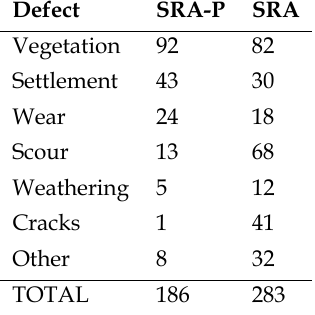
Table 4. The most common types of defects detected by SRA-P and SRA during 2005.